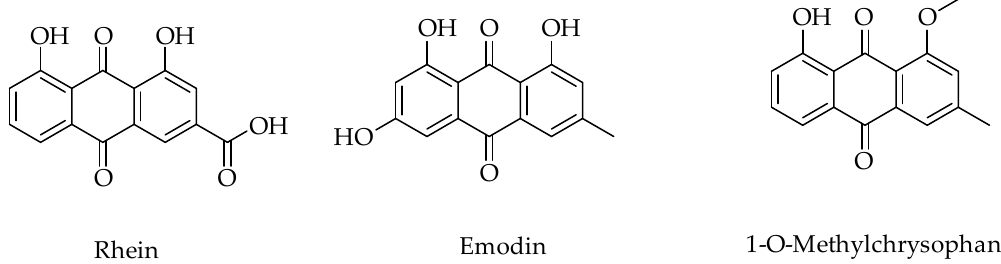
Figure 2. Chemical structure of fourteen compounds that were tentatively identified.